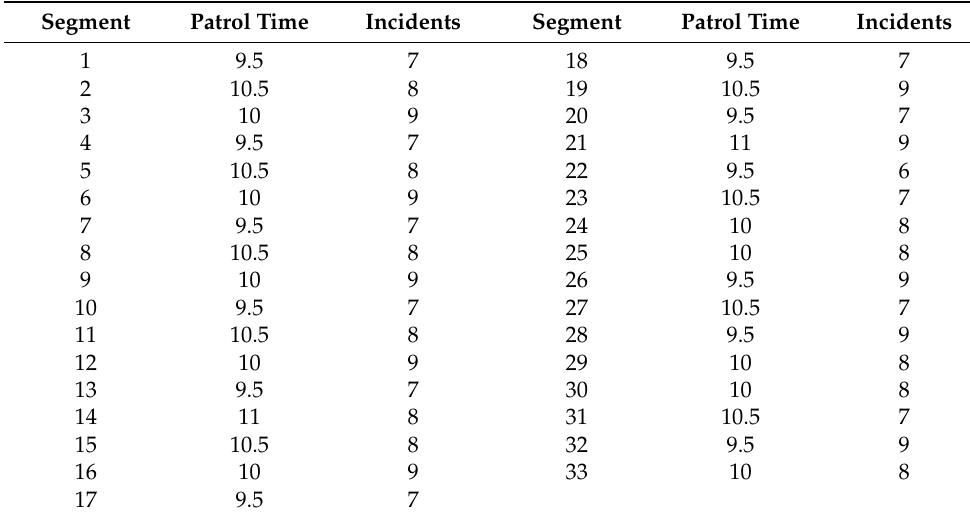
Table 4. Number of road network incidents and road patrol time.